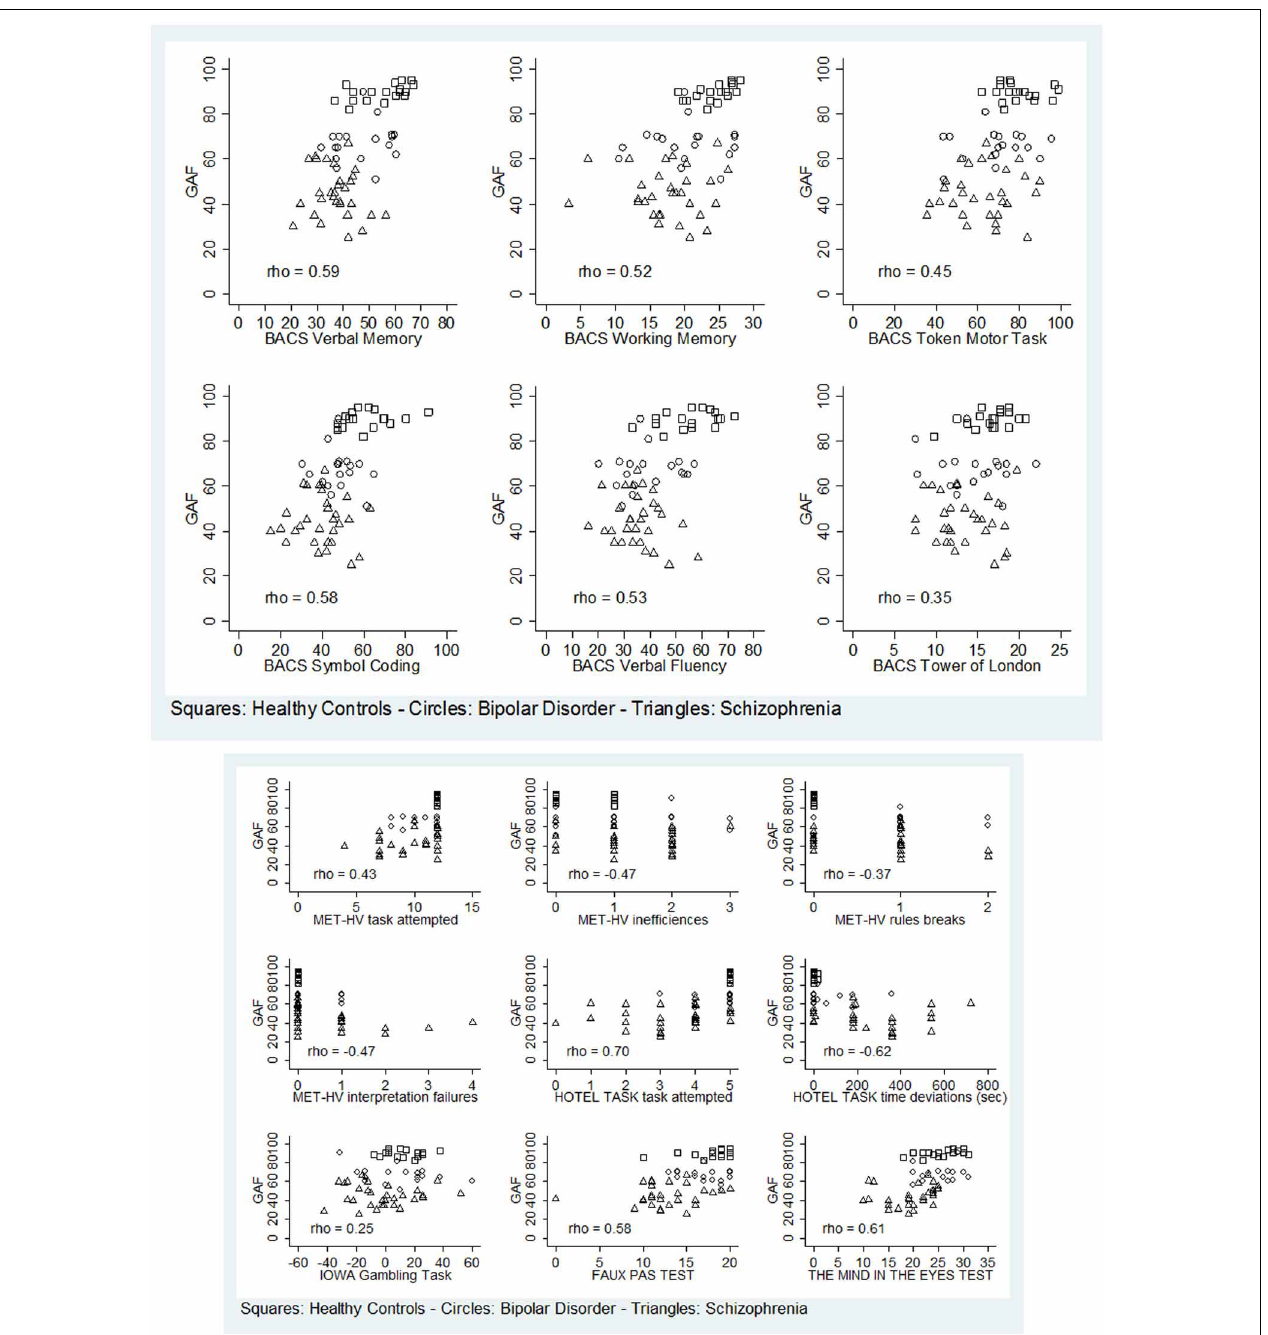
FIGURE 13 | Significant correlations between global functioning (GAF) and neuropsychological tasks (BACS)/ESCB